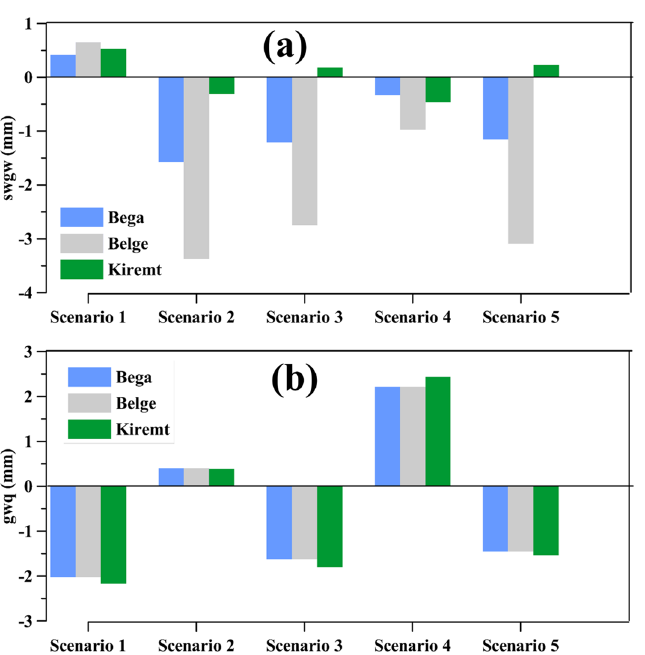
Figure 9. Seasonal surface water discharge to the aquifer (swgw) and groundwater discharge to the river (gwq) differences under the simulation scenarios from the baseline scenario